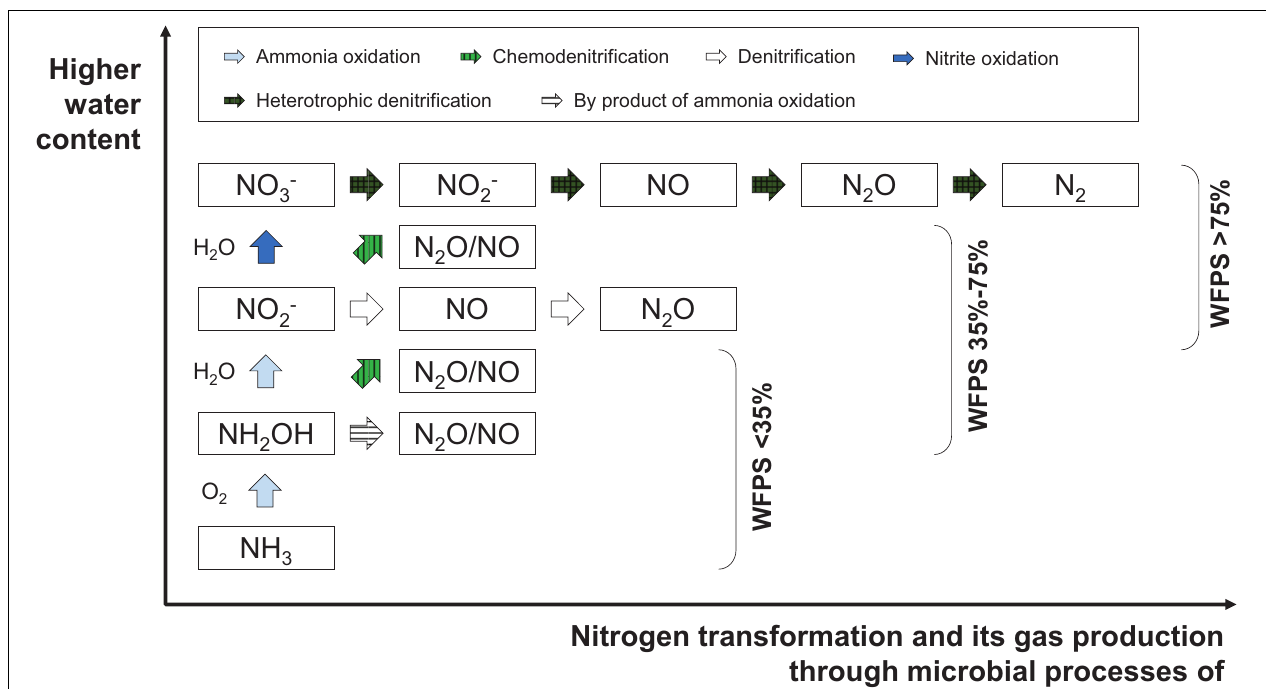
FIGURE 3 | A schematic diagram of the main pathways of nitrogen (N) transformation and its gas production vs. varied water content in substrate. The figure is remade by compilation of the following research: Bateman and Baggs (2005), Gleeson et al. (2010), Kool et al. (2011), Zhu et al. (2013).